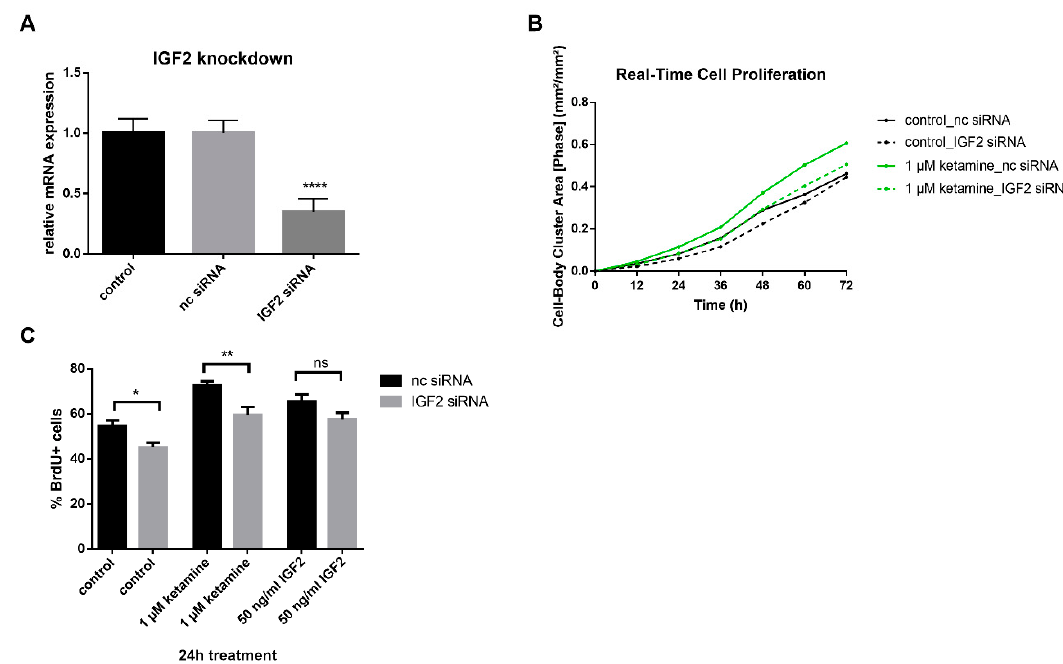
Figure 6. NPC cell proliferation is reduced after IGF2 knockdown. ( A ) Confirmation of IGF2 knockdown by qPCR analysis at 24 h. Expression of IGF2 was reduced by up to 66%. ( B ) The representative time-response curve of proliferating cells showing a reduction of ketamine’s e ff ect on proliferation after IGF2 knockdown. Cells were treated with 2 µ M IGF2 siRNA or nc siRNA for 24 h. After washout, ketamine was added and confluency of cells was determined with the IncuCyte ® NeuroTrack Software indicated as the Cell-Body Cluster Area. ( C ) An additional method showing the reduction of cell proliferation after IGF2 siRNA knockdown. After the knockdown, cells were treated with 1 µ M ketamine, 50 ng / mL IGF2 or 0.01% dimethyl sulfoxide (DMSO) control for 24 h, before 10 µ M BrdU labeling solution was added for an additional 4 h. The histogram shows BrdU-expressing cells. BrdU incorporation was quantified by the calculation of BrdU + cells as a percentage of the total number of 4 ′ ,6-diamidino-2-phenylindole (DAPI)-labeled nuclei using ImageJ (Fiji) for image analysis. The data represent the means of three independent experiments. Error bars were calculated using ±SEM. p-values were calculated against the 0.01% DMSO control.